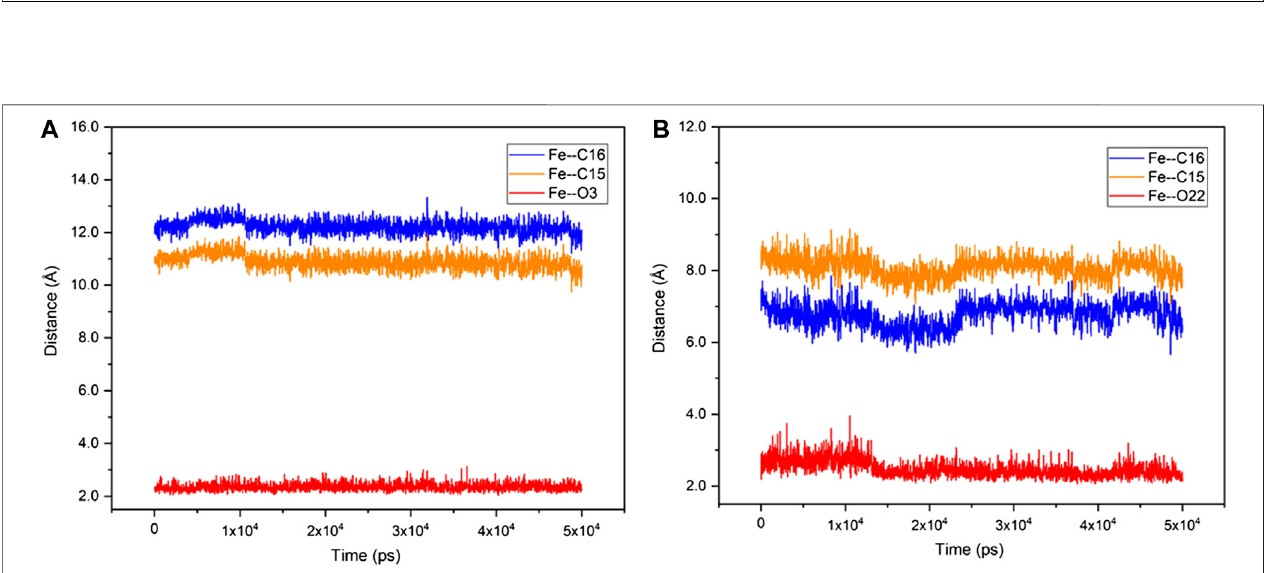
FIGURE 4 | The fl uctuation of the distance of Fe — O3 (red), Fe — C15 (orange) and Fe — C16 (blue) in CYP109B1-Progesterone systems (A) and CYP109B1- Progesterone systems (B) during the MD simulations.